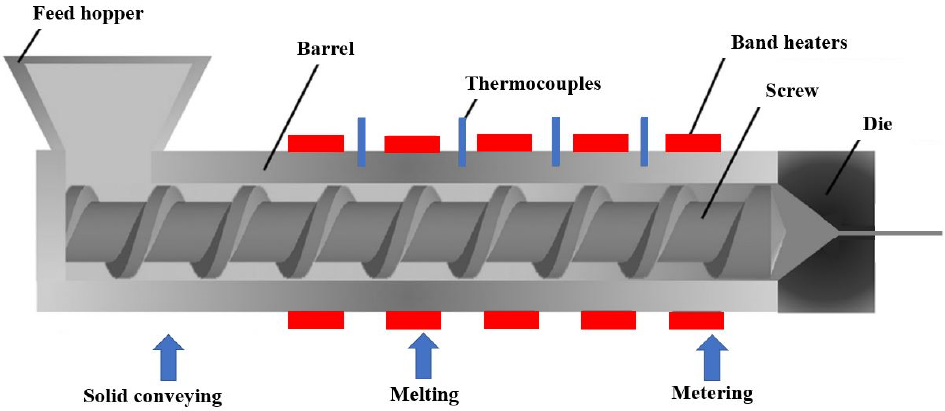
Figure 2. Extrusion of process of materials (adapted from Zhang et al. [22]). (Red blocks indicate band heaters) .